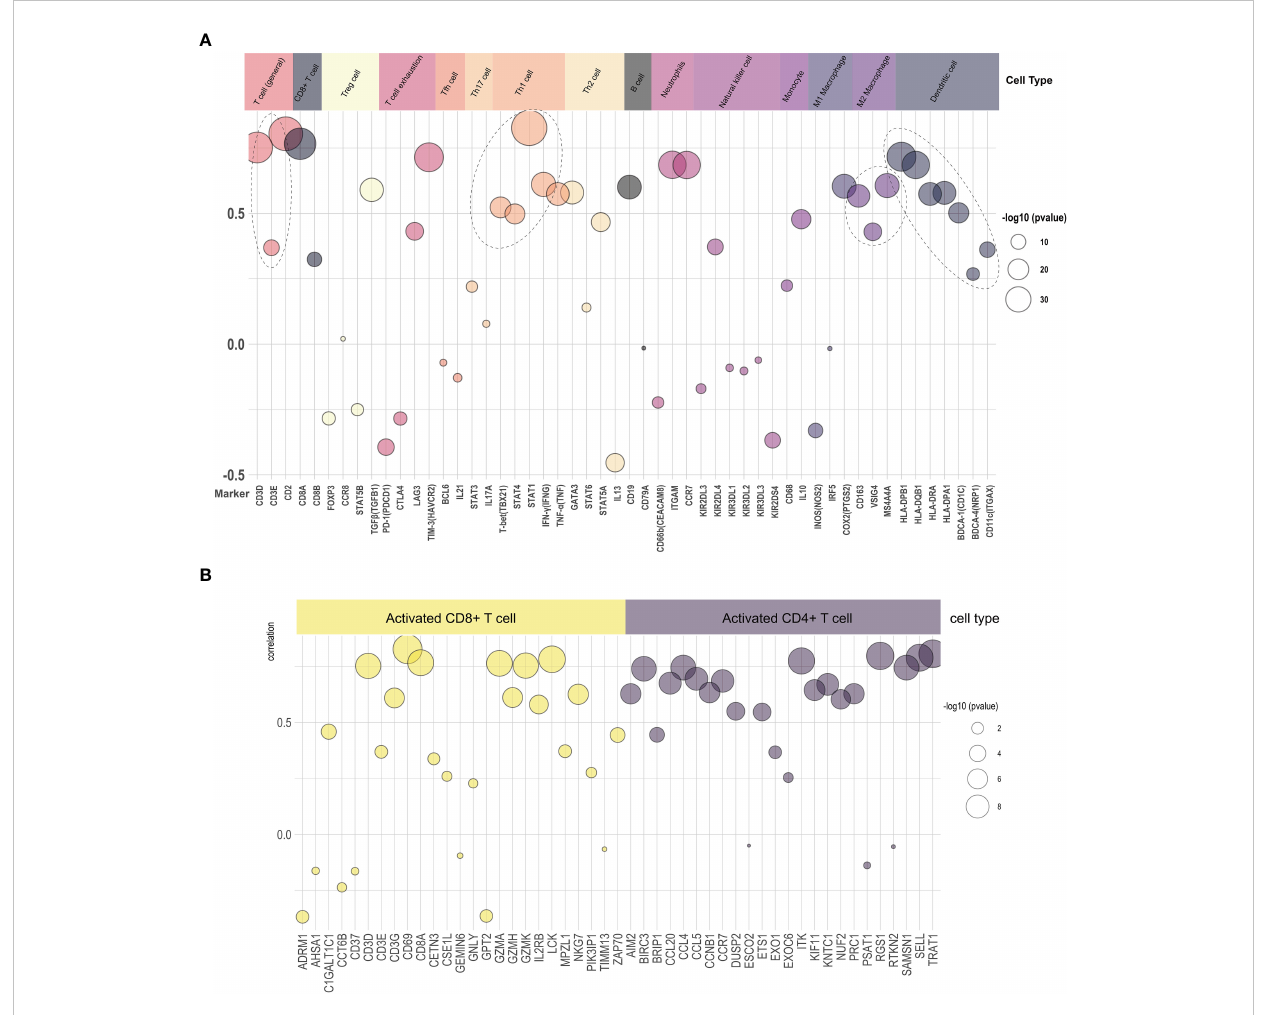
FIGURE 4 Relationship of LAMP3 expression with marker gene sets of various immune cells. (A) The association among LAMP3 level with marker genes in immune cells and (B) CD4+ T cells and CD8+ T cells. LAMP3, lysosome-associated membrane glycoprotein 3; Circle size indicated -log10 (p value), Y-axis displayed the correlation coef fi cient.